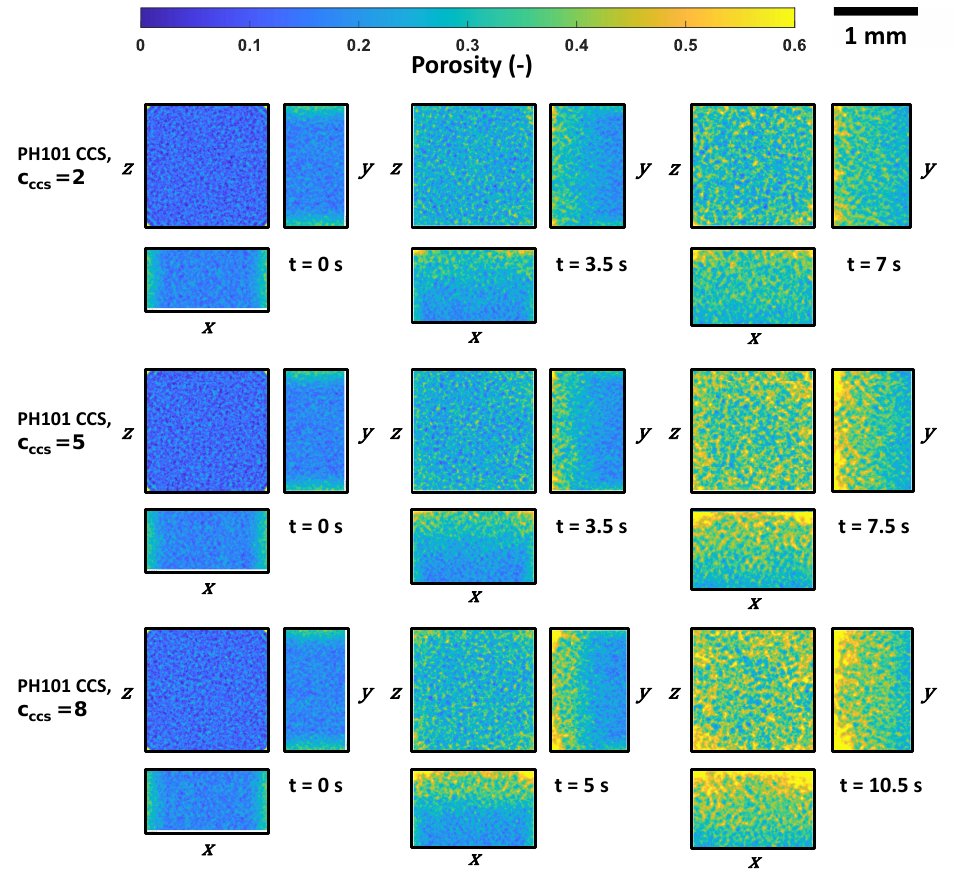
Figure 10. Cumulative porosity maps of the tablet at three different time points during the swelling process of PH101/CCS tablets. The cuboid subsection has a size of 1400 × 1400 × 800 pixels and was selected at the centre of the tablet for this analysis.